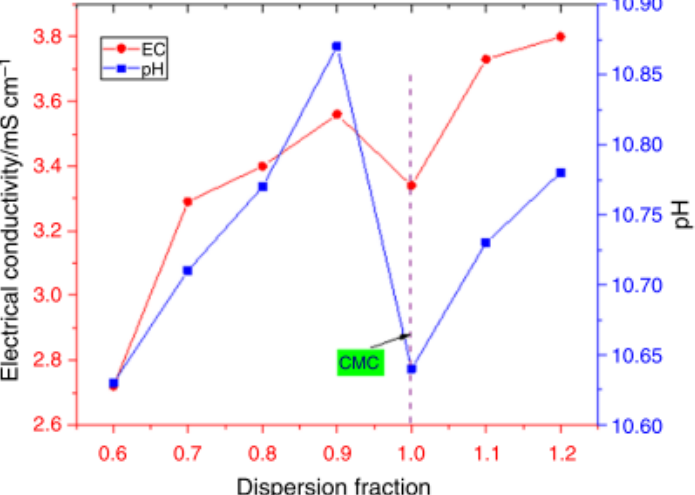
Figure 20. Effect of dispersion fraction on electrical conductivity and pH of 0.5 vol% MgO-ZnO/DIW NF. Adapted from [77].